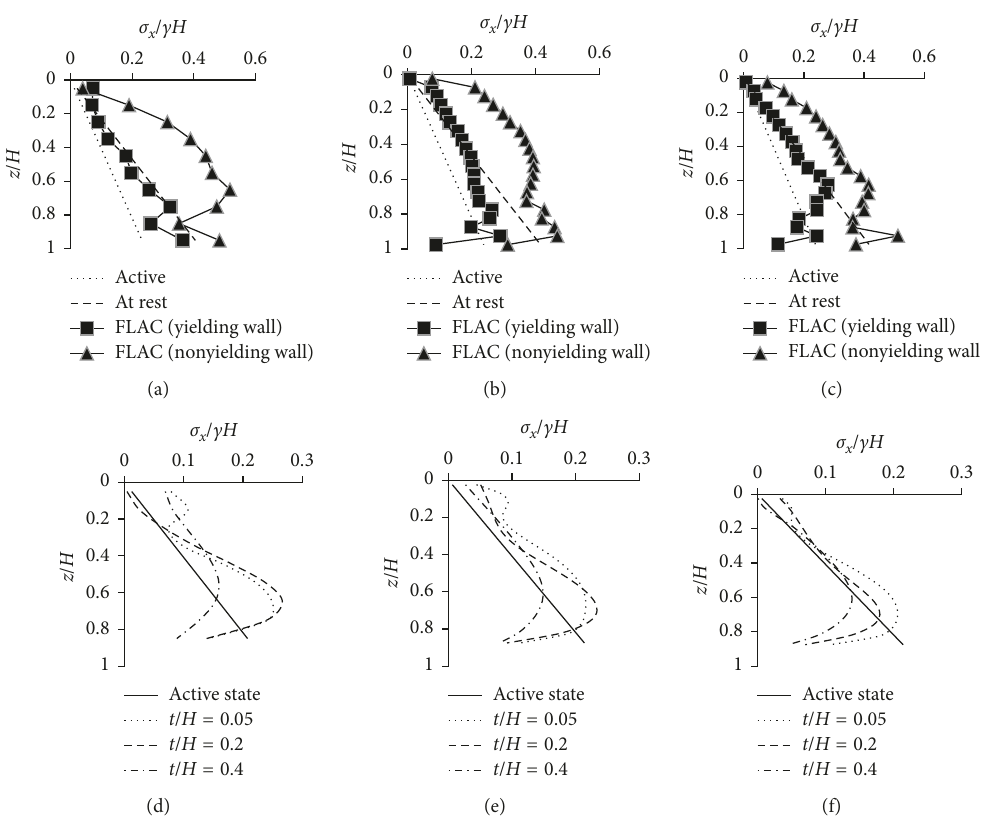
Figure 3: Lateral earth pressure distribution on the cantilever retaining walls: (a, b, and c) yielding and nonyielding conditions without using geofoam and (d, e, and f) yielding condition by using EPS15. (a) H